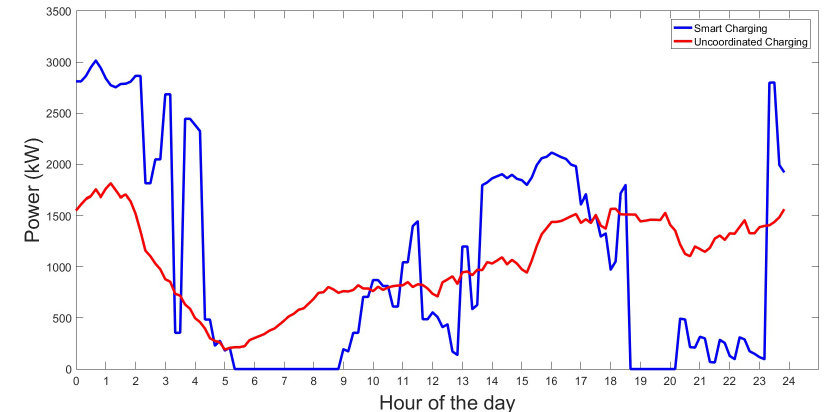
Figure 6. Smart Charging and Uncoordinated Charging Patterns, for Scenario